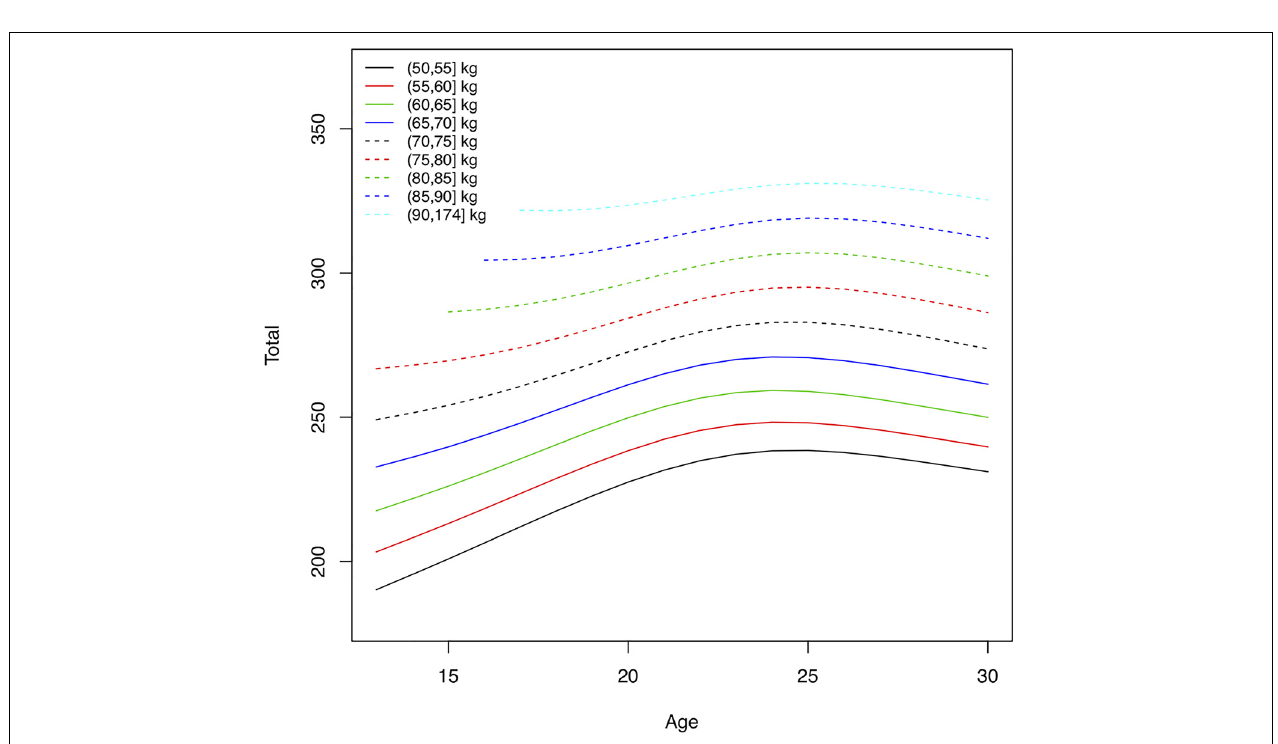
FIGURE 4 | Absolute performance levels in total weight lifted (kg), at the 90th percentile, by age and body mass for women. Lines represent total weight lifted for athletes with different body mass.